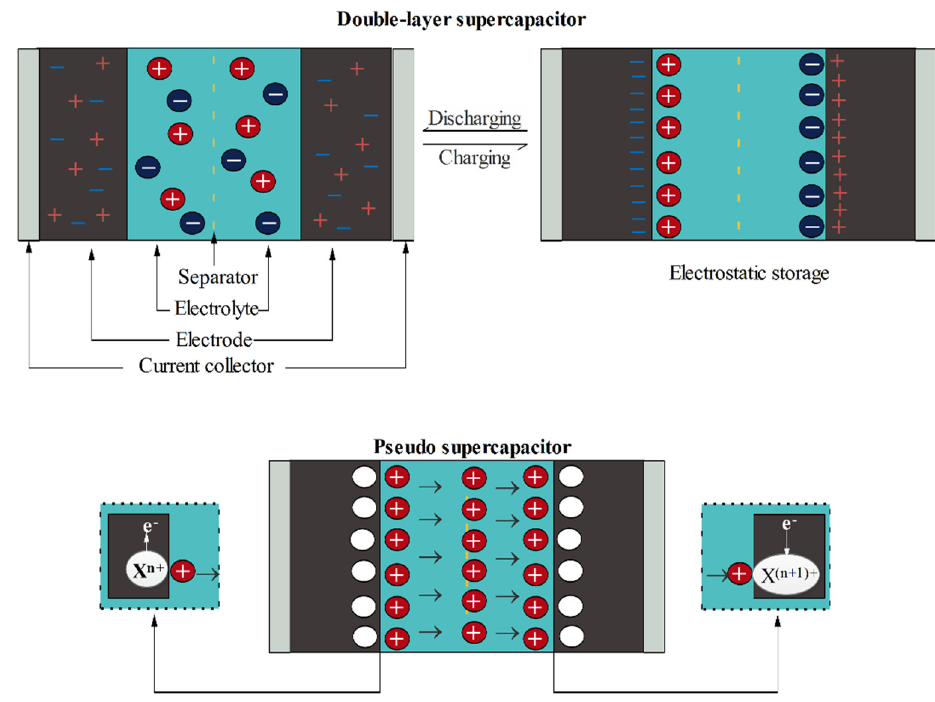
Figure 10. Schematic illustration of various supercapacitor types.